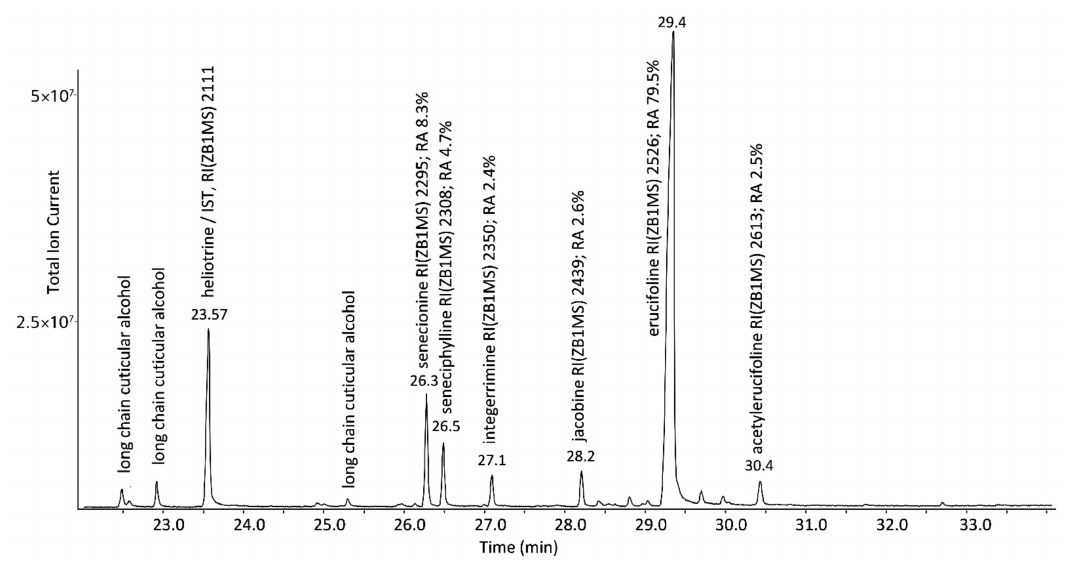
Figure 1. Total ion chromatogram (TIC) of a GC-MS analysis for identification and determination of the relative abundance (RA) of the PA-bouquet of J. vulgaris plant material utilized in this